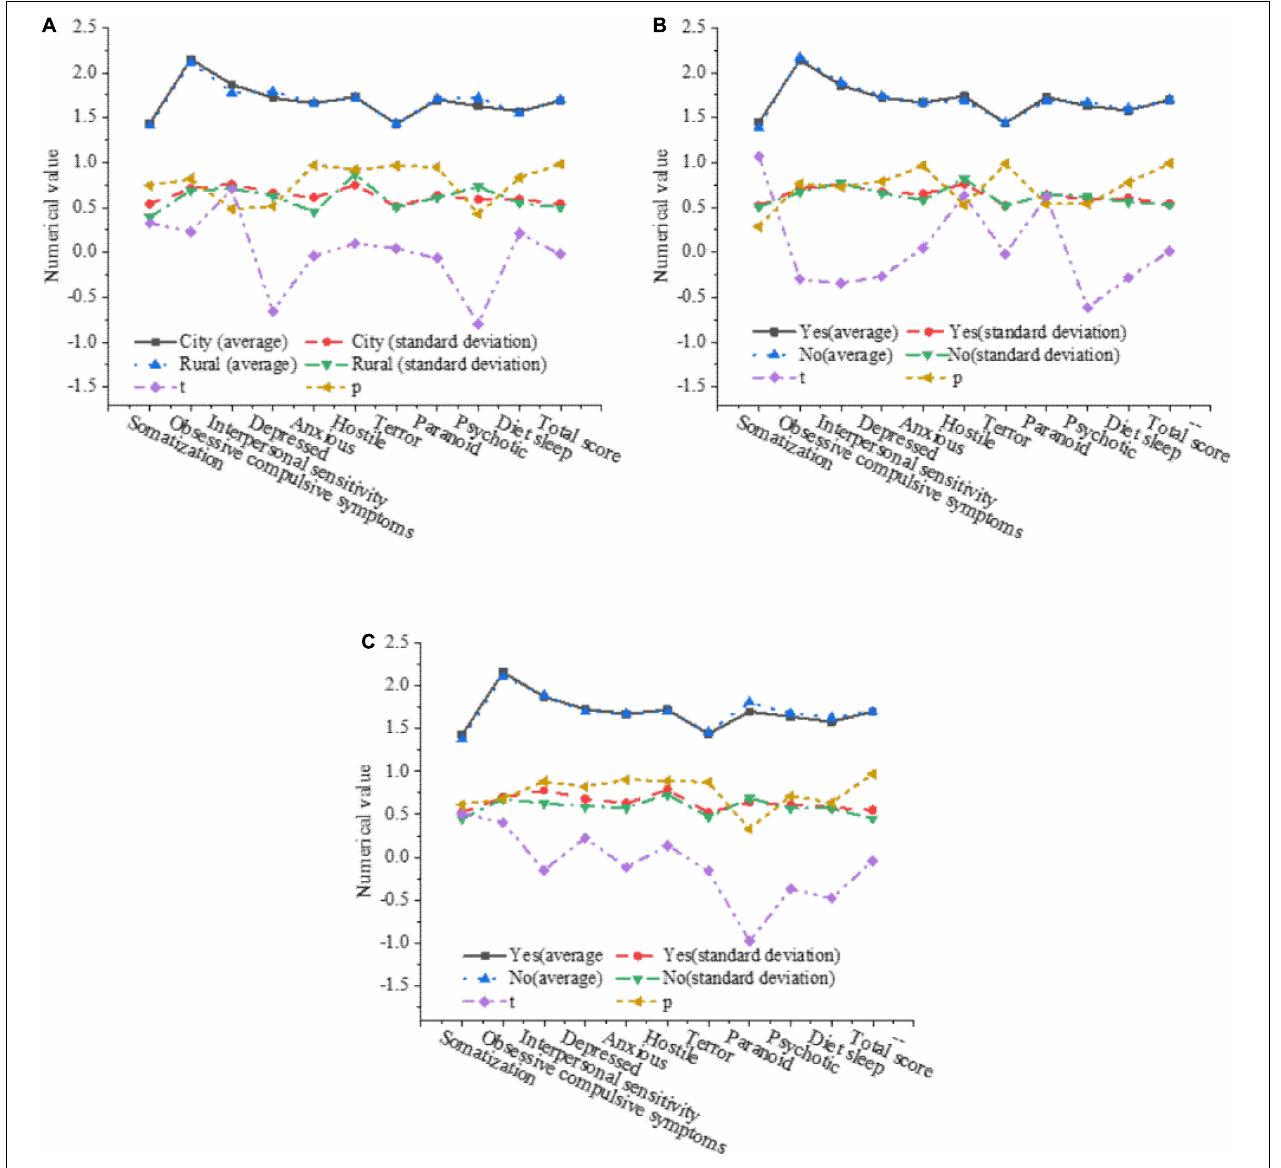
FIGURE 6 | The influence of various factors on the mental health level of college students. (A) The influence of the birthplace on the mental health of college students. (B) The influence of whether it is the only child on the psychological health of college students. (C) The influence of single-parent families on the mental health of college